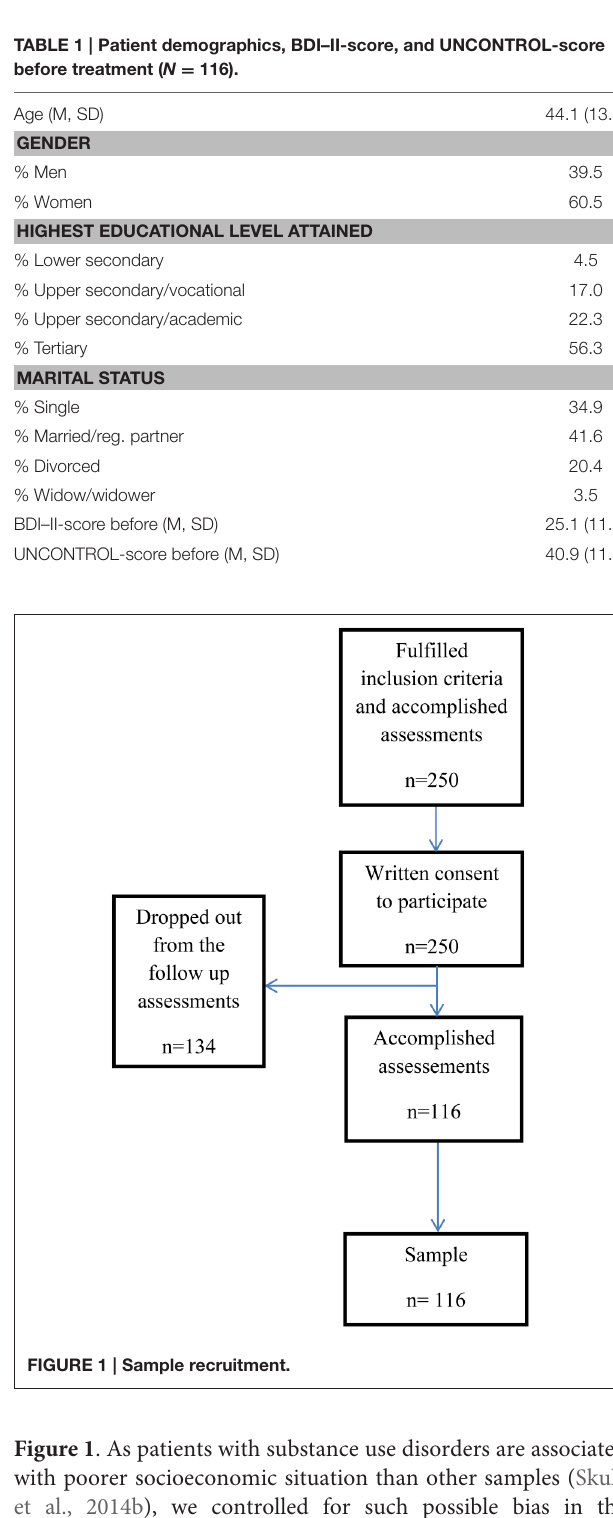
Figure 1 . As patients with substance use disorders are